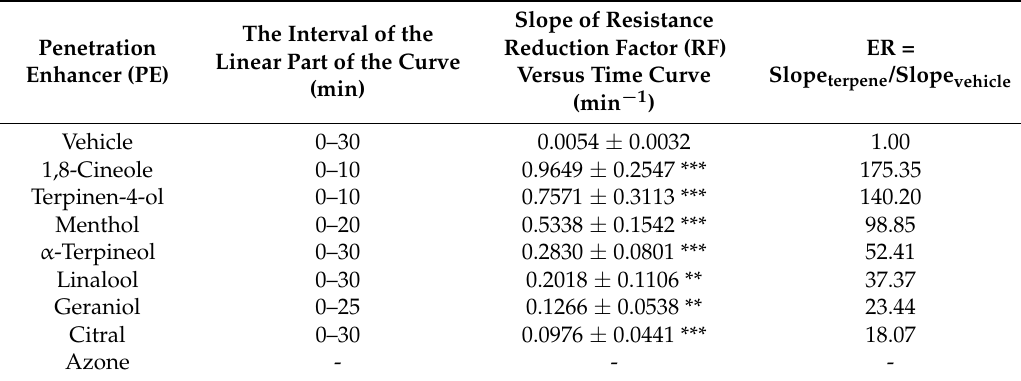
Table 2. The enhancement ratio (ER)values of different oxygen-containing terpenes calculated by skin electrical resistance (SER) kinetics with the use of the vehicle of ethanol- phosphate buffered saline (PBS) (1:1, v / v ) ( n = 5). The Interval of the Penetration Linear Part of the Curve Enhancer (PE) (min)